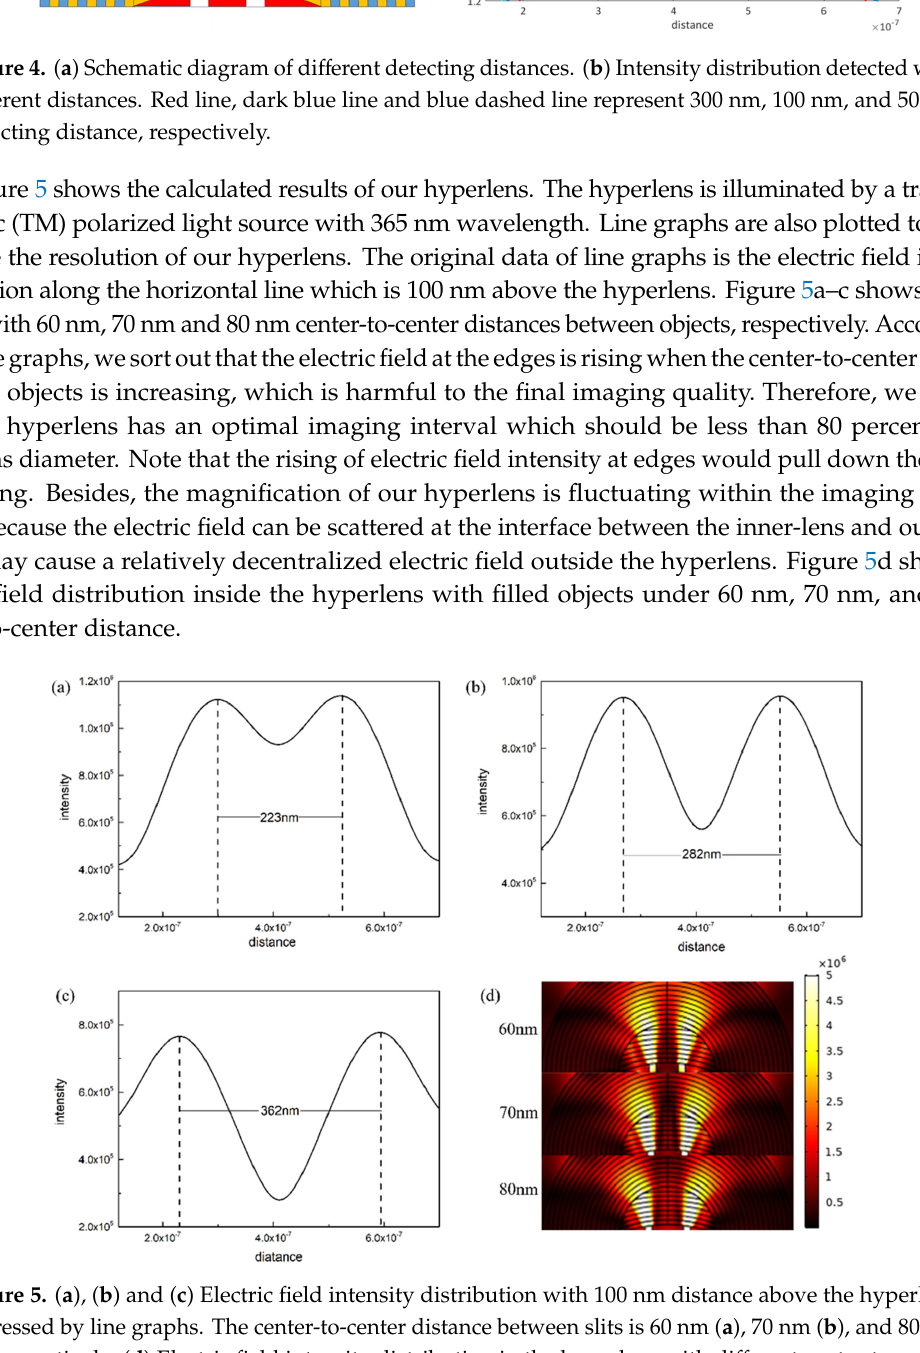
Figure 5. ( a ), ( b ) and ( c ) Electric field intensity distribution with 100 nm distance above the hyperlens expressed by line graphs. The center-to-center distance between slits is 60 nm ( a ), 70 nm ( b ), and 80 nm ( c ), respectively. ( d ) Electric field intensity distribution in the hyperlens with di ff erent center-to-center distances between the